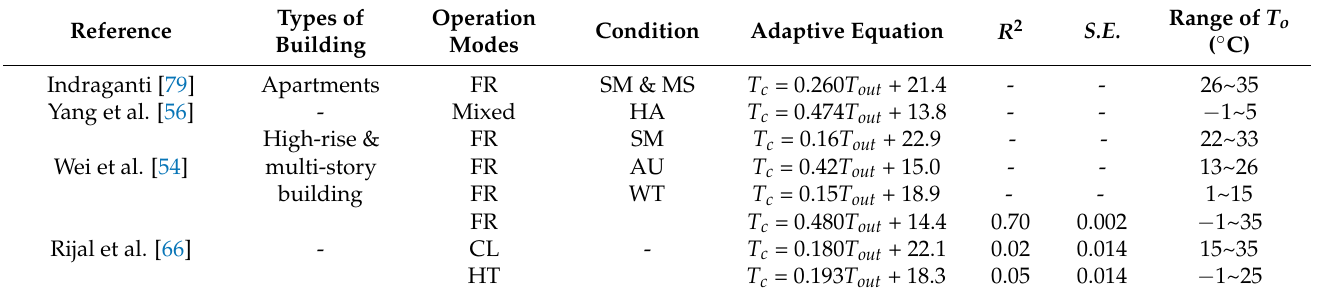
Figure 9. Correlation of mean comfort temperature with outdoor temperature.